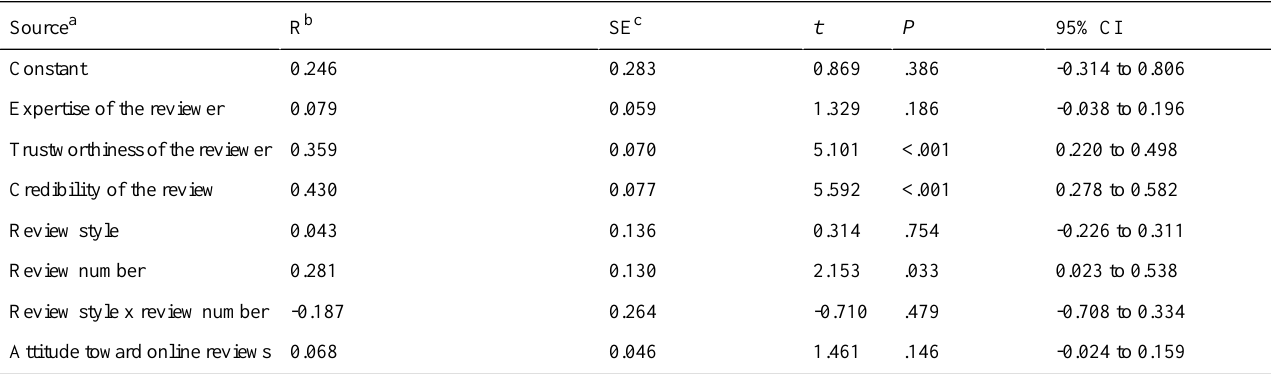
Table 5. Results of the moderated mediation analyses for the outcome variable, attitude toward the